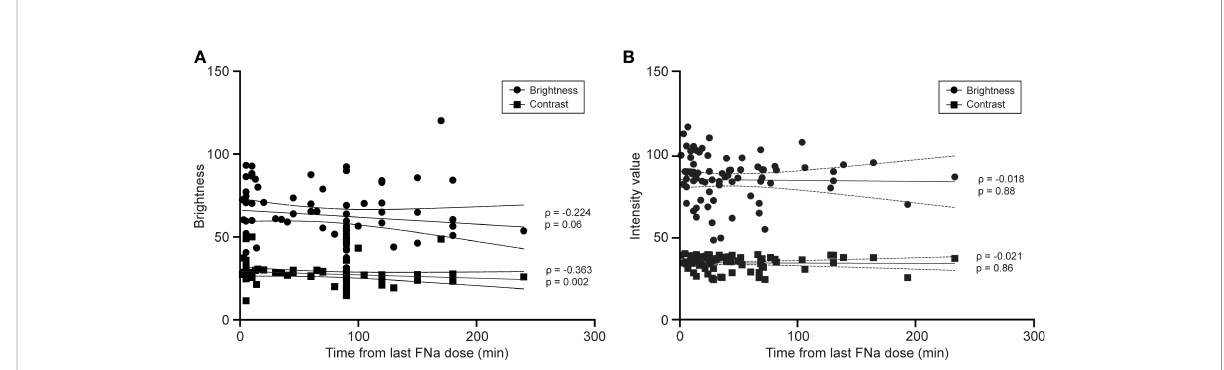
FIGURE 4 Line graphs showing the correlation between image quality and image timing. (A) For the ex vivo study, there is a small negative correlation between image contrast and the time interval between fl uorescein sodium dosing and imaging ( r = -0.363, p = 0.002). The result for image brightness and timing of imaging was not statistically signi fi cant ( r = -0.224, p = 0.06). (B) For the in vivo study, no correlation was observed between image brightness ( r = -0.018, p = 0.88) and contrast ( r = -0.021, p = 0.86) and timing of imaging. Used with permission from Barrow Neurological Institute, Phoenix,